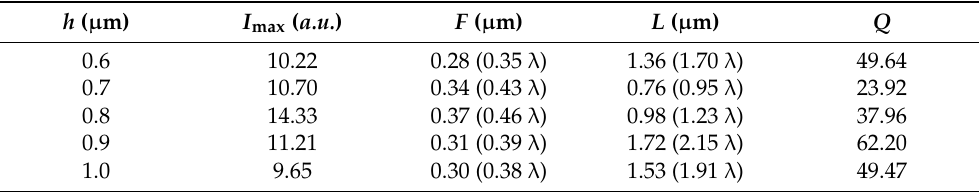
Table 2. Characteristic parameters of the SPP − PNJ excited with different thicknesses h of the mi- crodisk.